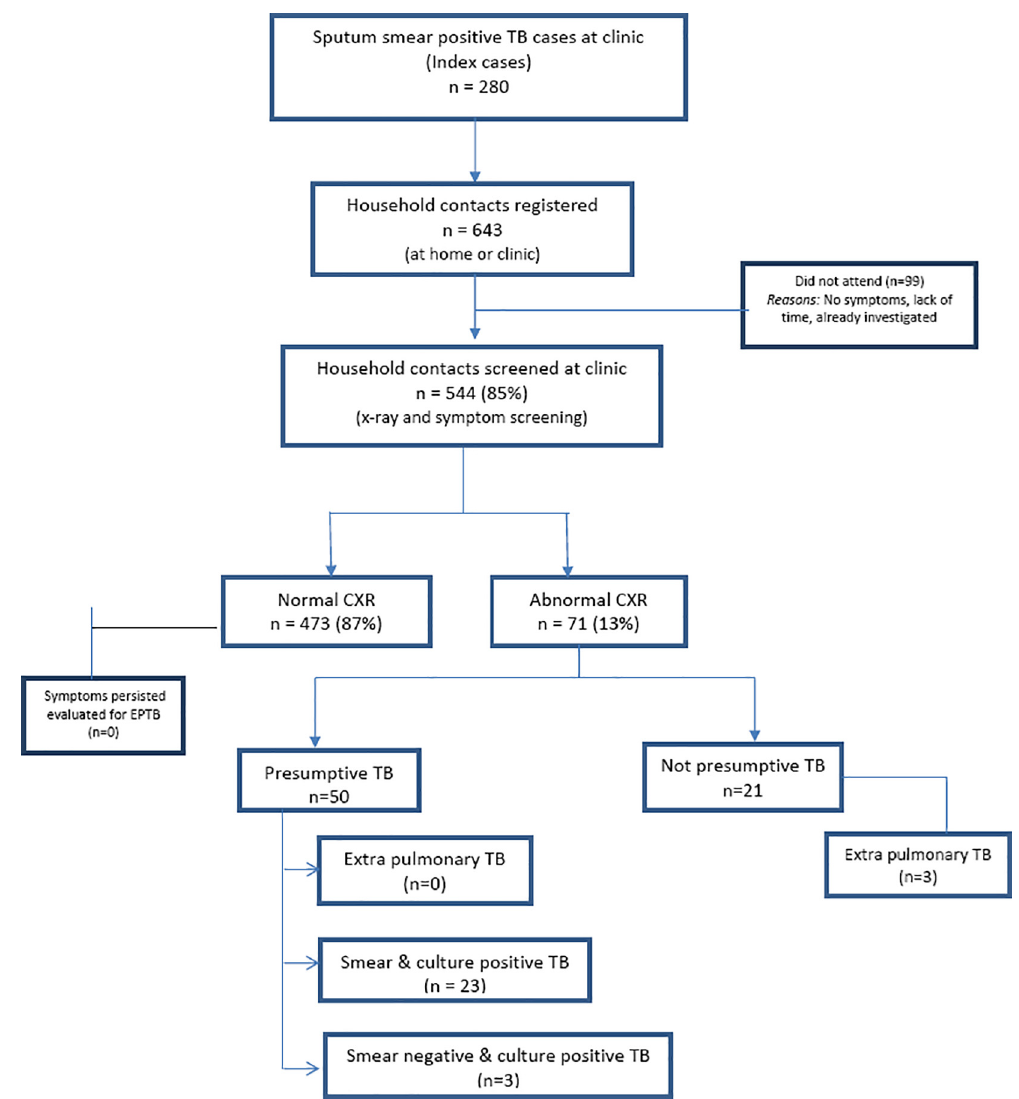
Fig 1. Flow chart of index TB cases and their household contacts, Chennai,